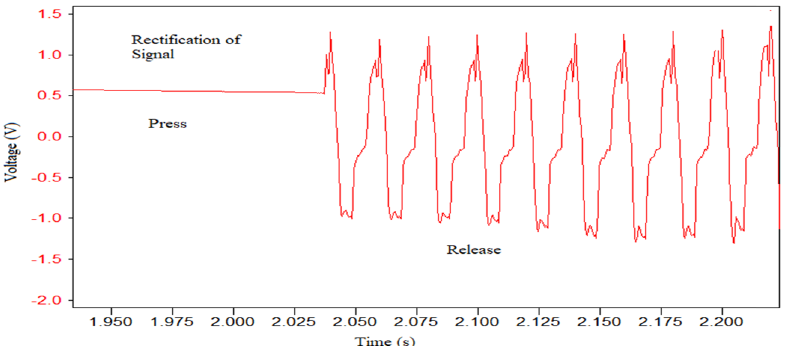
Figure 11: Voltage generation based on press and release at the ZnO NSs –